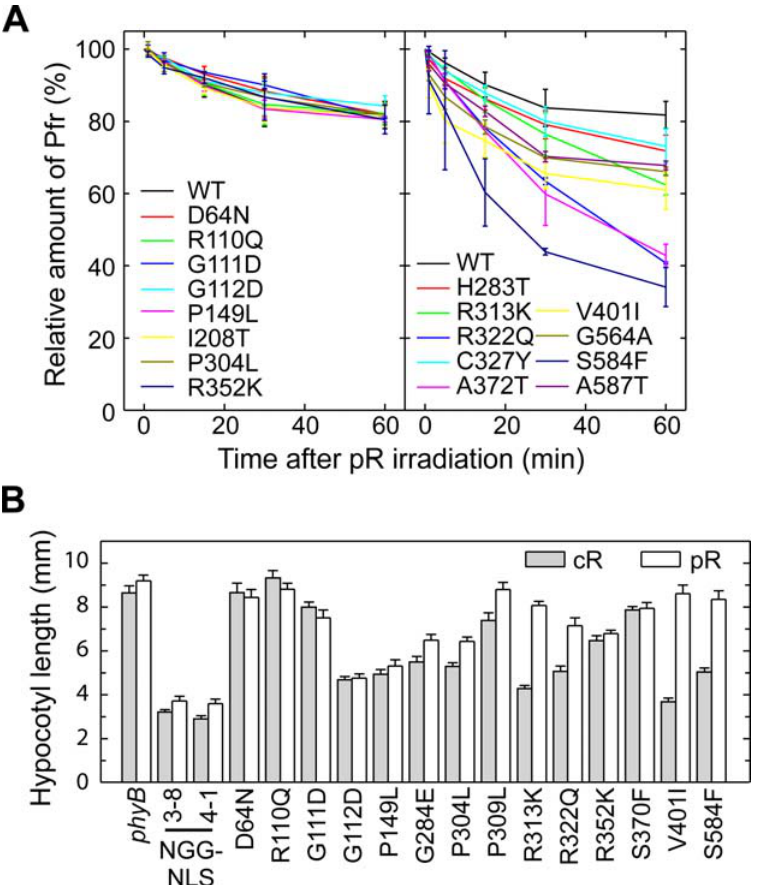
Figure 4. Dark Reversion Rates in the Mutant N651 Fragments. (A) In vitro dark reversion rates measured by spectrophotometry. Holoproteins were converted to Pfr by irradiation with saturating R (89 m mol m 2 2 sec 2 1 ) for 10 min, and then dark reversion from Pfr to Pr was monitored with a spectrophotometer. The level of Pfr at the beginning of the measurement was set to 100%. The incubation temperature was 22 u C. Each value represents the mean of three independent measurements. (B) Hypocotyl responses in mutant lines to intermittent pR at 4 hr intervals. Plants were grown under intermittent pR (55.2 m mol m 2 2 sec 2 1 for 5 min) (open) or under cR (2.3 m mol m 2 2 sec 2 1 ) (shaded) for 5 days. Data are the mean 6 SE ( n